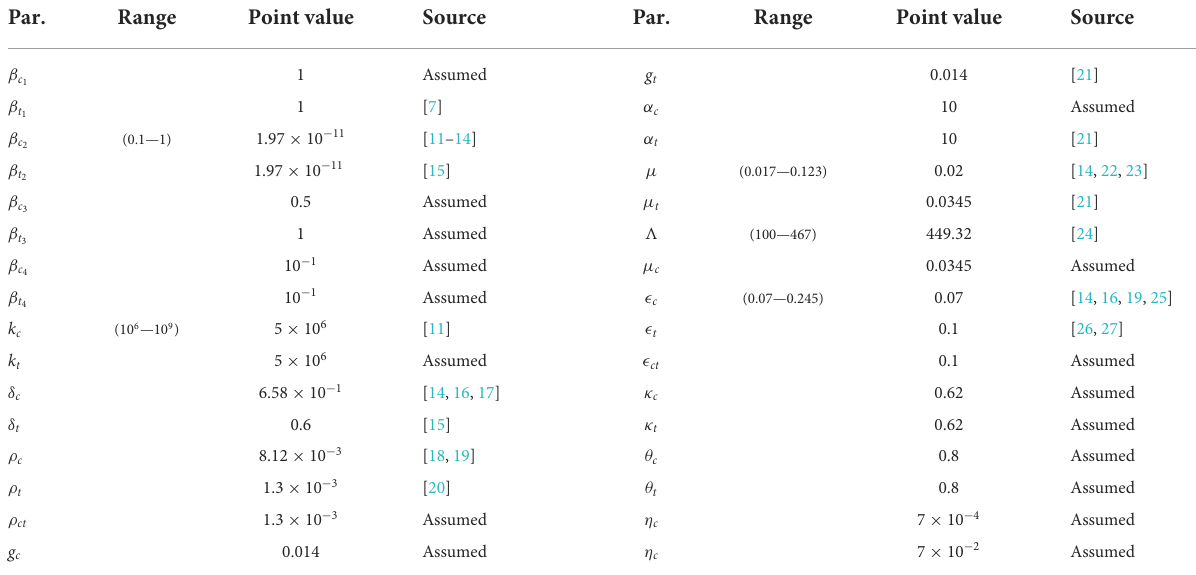
TABLE 1 Parameter values used for numerical simulation.